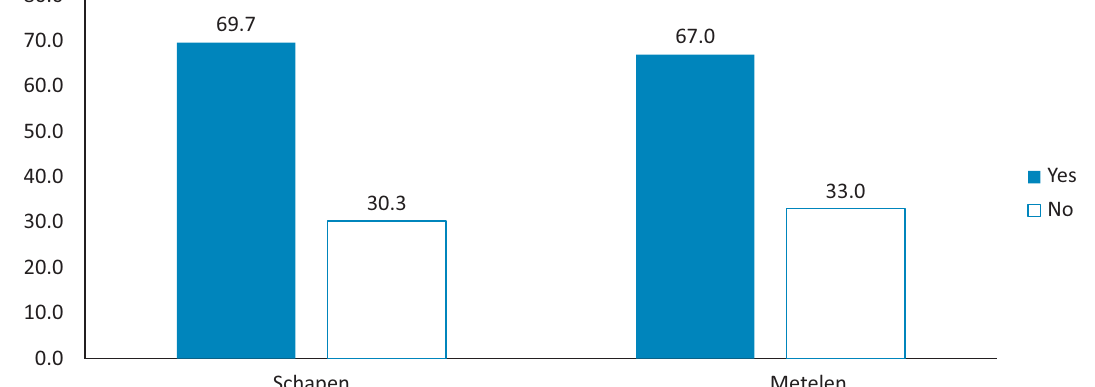
Figure 1. Are you in digital contact with your